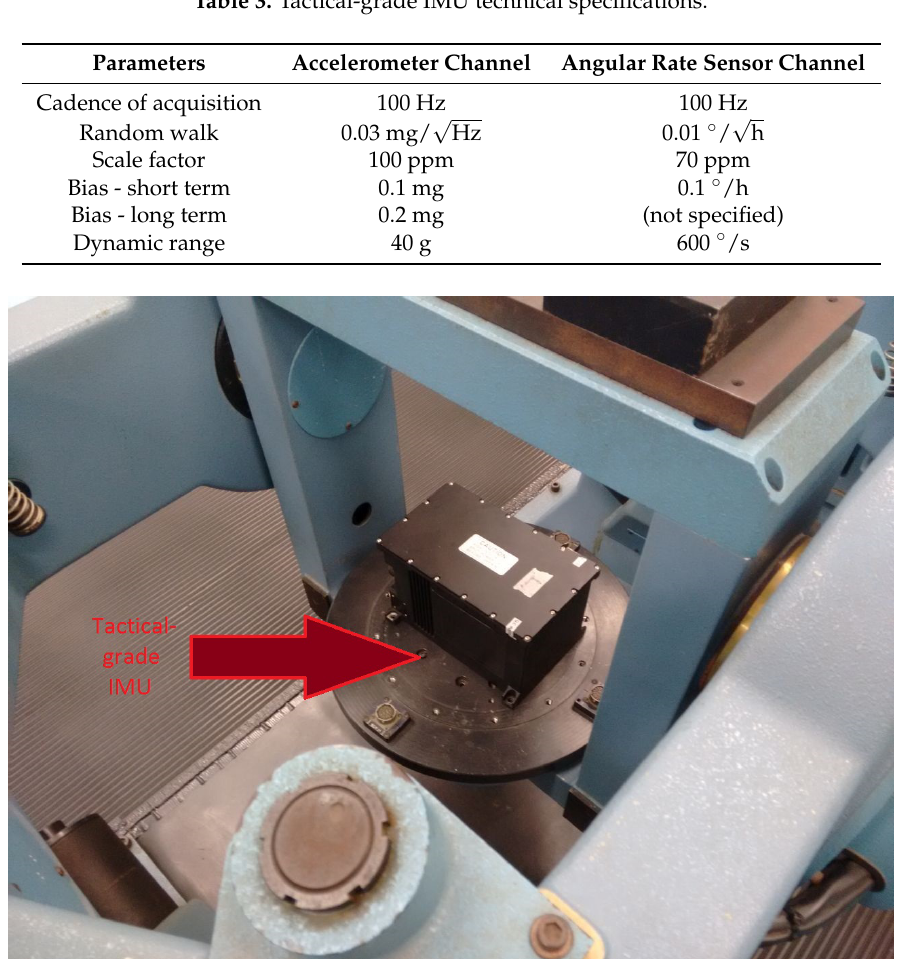
Table 3. Tactical-grade IMU technical specifications.